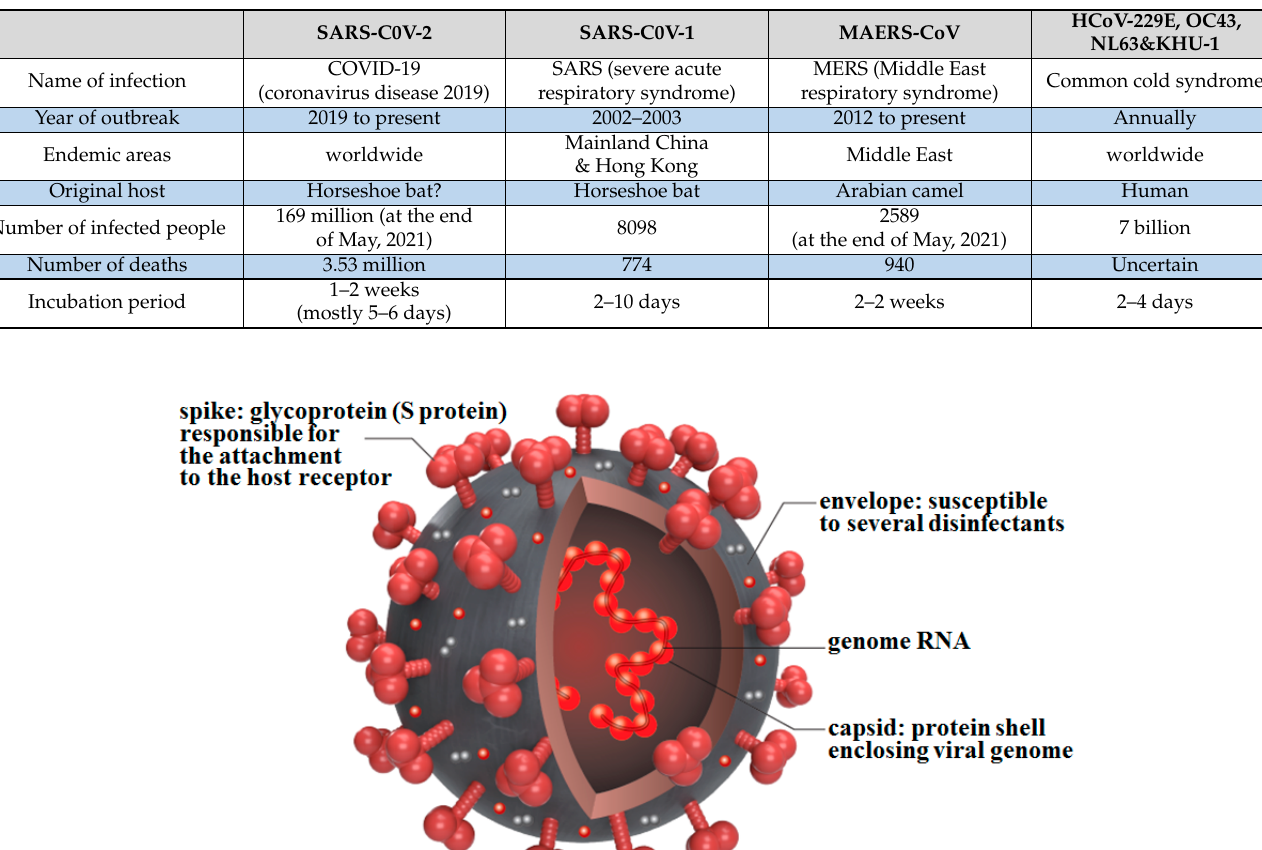
Table 1. Characteristics of coronavirus that infects humans.